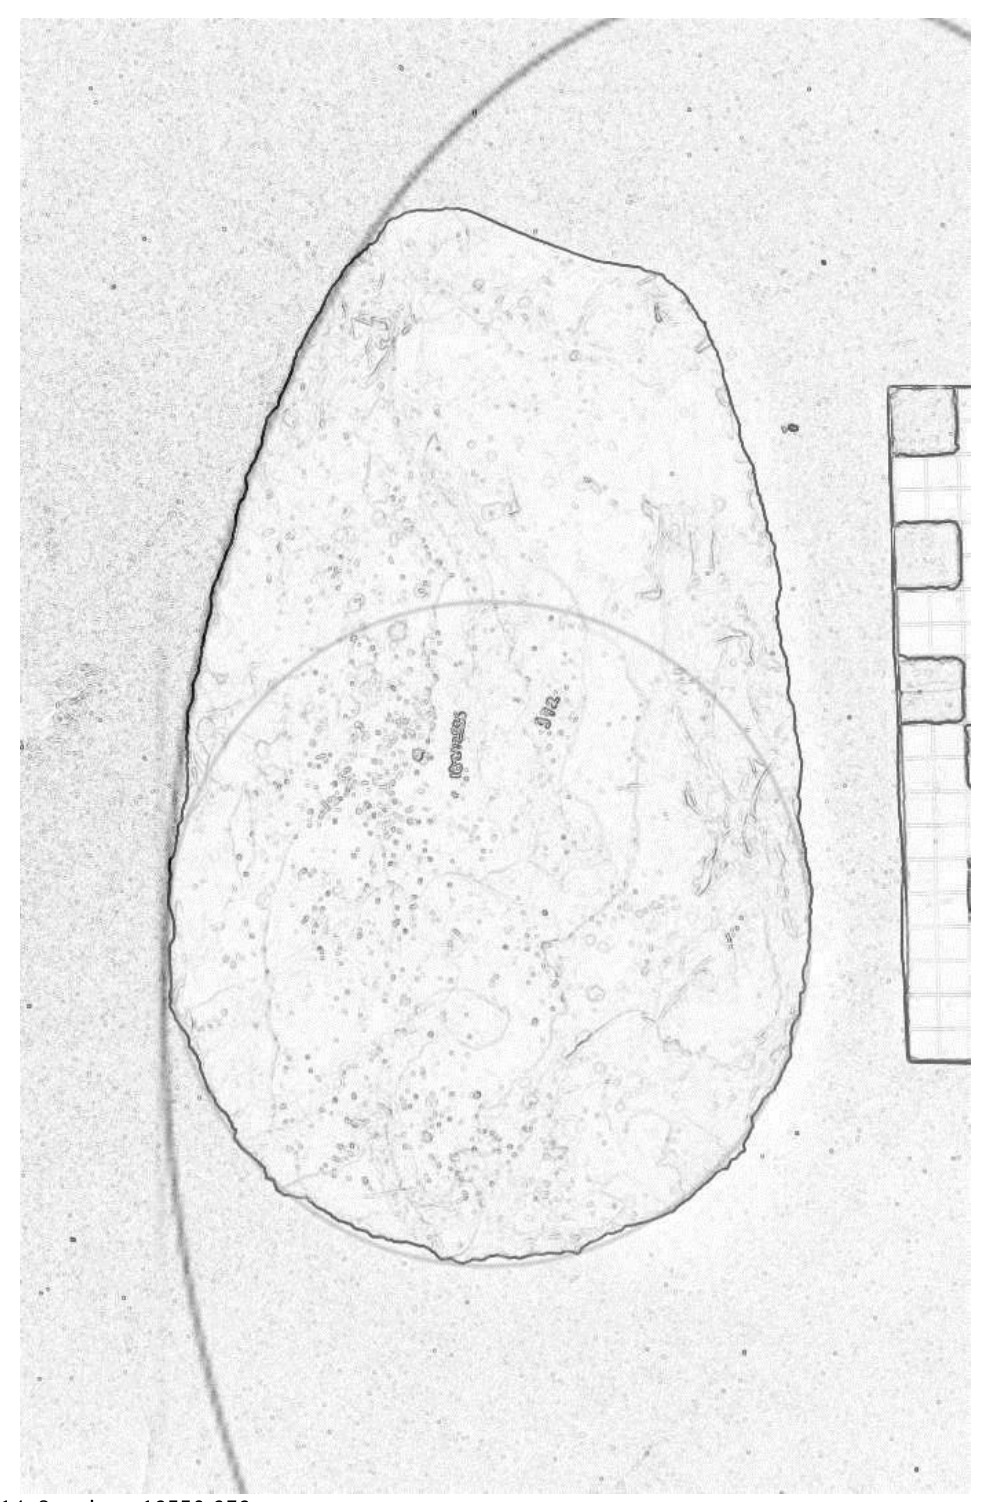
Figure 14. Specimen